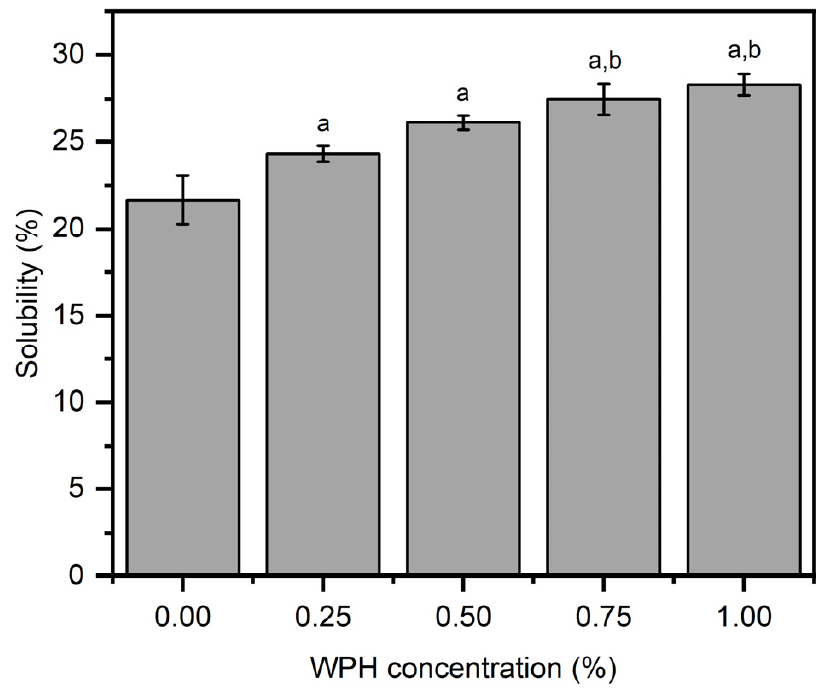
Figure 2. The solubility properties of chitosan/WPH films containing different concentrations of WPH. Data are presented as an average of three measurements ± standard deviation. Values with different letters on the top of bars are significantly different ( p < 0.05) and determined by using a Bonferroni post hoc test in a one-way ANOVA analysis—a and b are relative to films comprising 0 wt% and 0.25 wt% WPH, respectively.